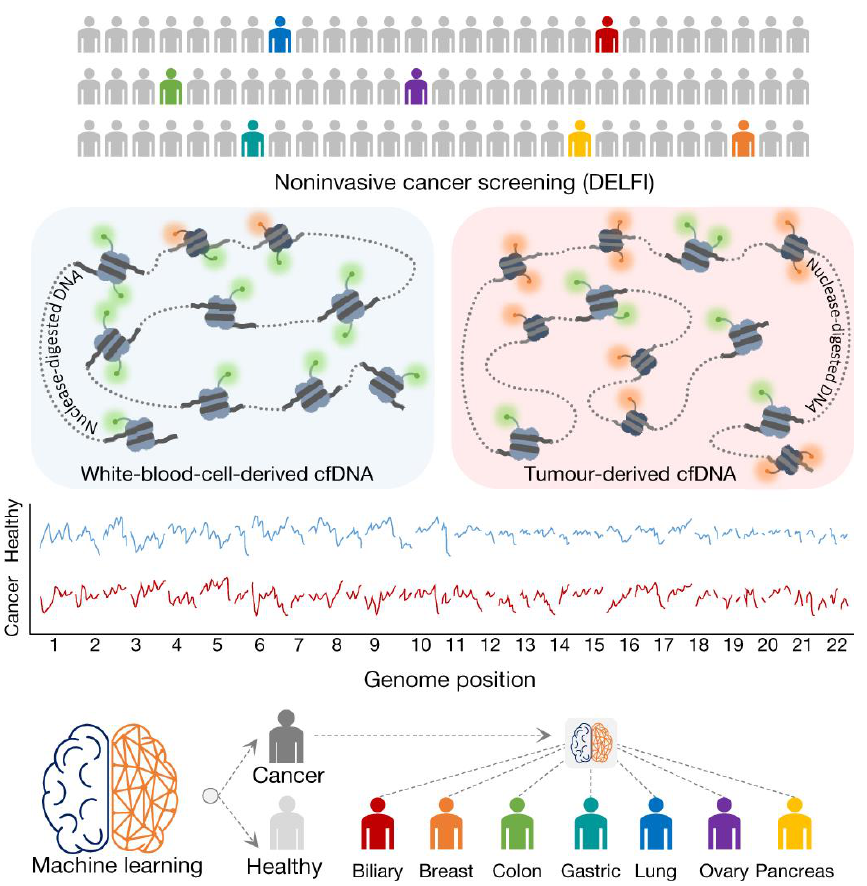
Figure 8. Schematic of DELFI approach. Cristiano et al. [233]. Cancer-specific fragment profiles are generated through WGS of cfDNA isolated from plasma and compared to profiles generated from healthy individuals. Unique fragment alterations at specific loci can be mapped back to detect and identify specific cancer types. Used with